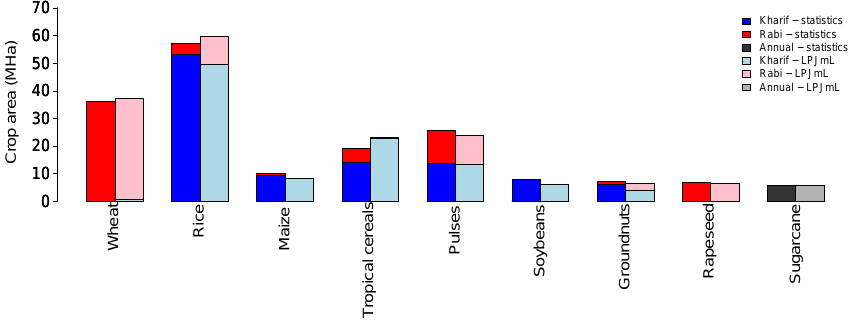
Figure 2. Total crop area in South Asia (India, Pakistan, Nepal and Bangladesh) for different crops in the two dominant growing seasons. National statistics (average of 2003–2008) versus LPJmL input data derived from MIRCA as described in Sect. 2.2. For the spatial distribution of crops between states and provinces of India and Pakistan, Nepal and Bangladesh, see Annex. Temperate and tropical roots and sunflower are not shown because they occupy relatively small areas; other perennial crops are not shown because there are no statistics available.